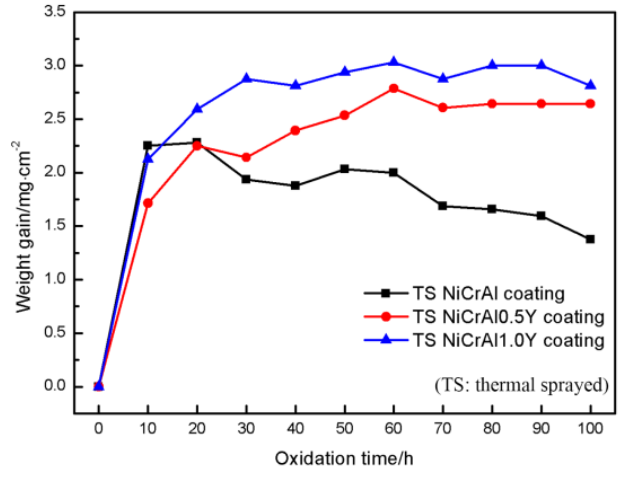
Figure 6. Weight gain curve of TS coatings during constant oxidation at 1100 ° C for 100 h. In addition, when the oxidation time is 20~100 h, because the element Y was added to the NiCrAl0.5Y and NiCrAl1.0Y coatings, the formation enthalpy of Y is lower than that of Al, Cr and O, and Y is preferentially oxidized to form Y 2 O 3 at high temperature, which is enriched at the interface between oxide film and alloy substrate. The bonding strength of Al 2 O 3 film and coating substrate can be significantly enhanced by refining Al 2 O 3 grains and pinning. At the same time, the diffusion rate of metal cations Al 3+ and